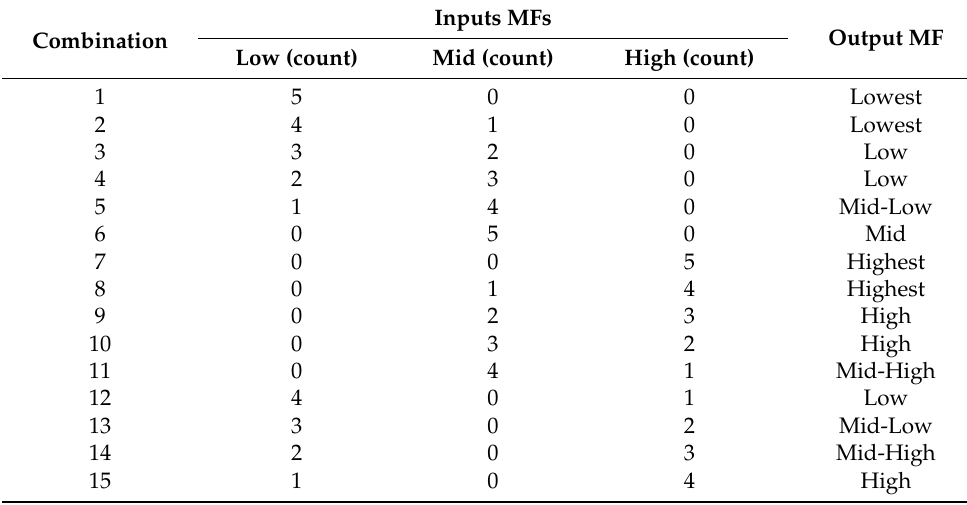
Table 12. The rules combination with output MFs.